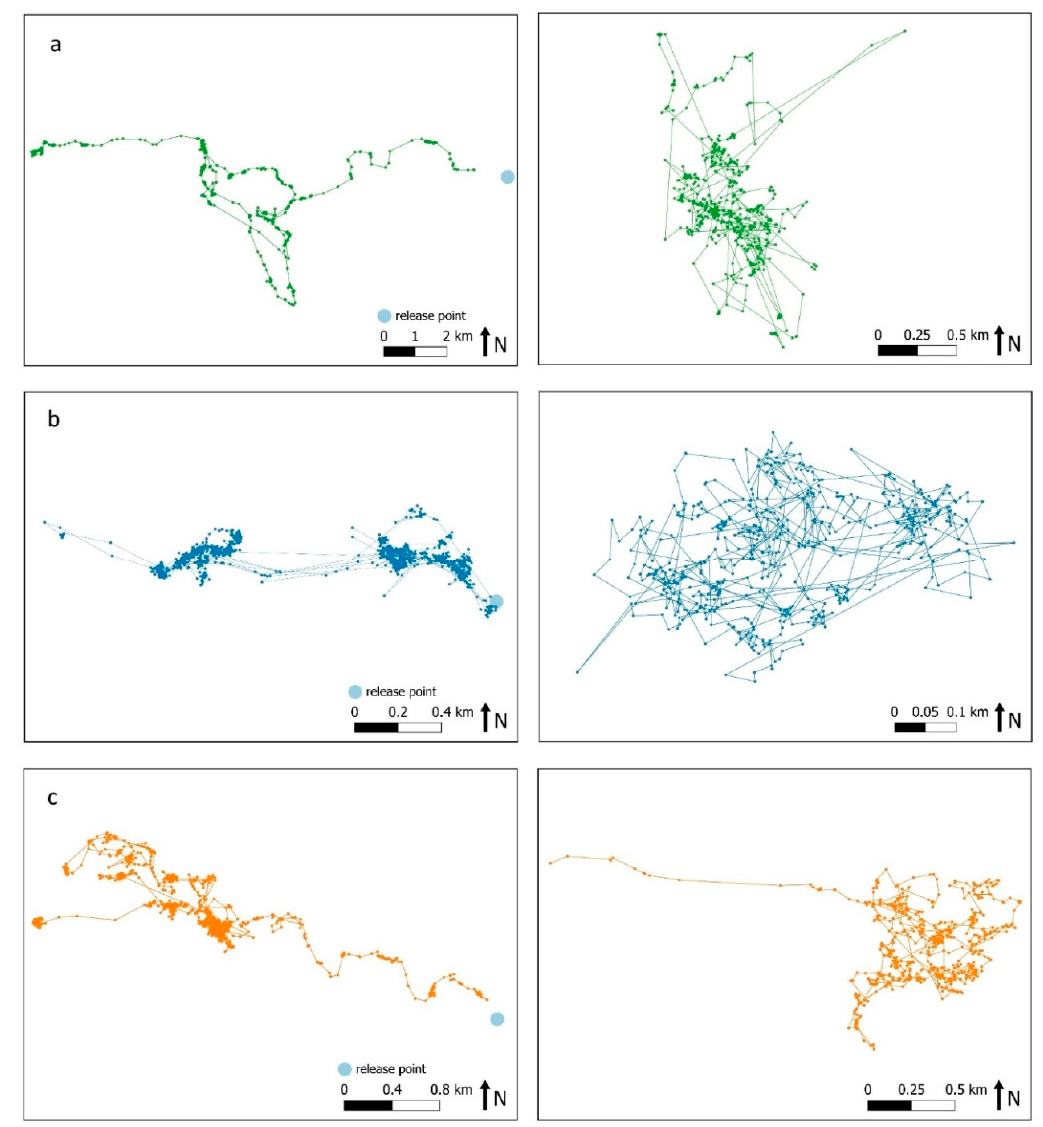
Figure 4. Movement of the three surviving individuals ( a ) 3F, ( b ) 186F and ( c ) 13M during the first month post-release using half-hour intervals (left) and during the 12th month post-release using one-hour intervals (right).